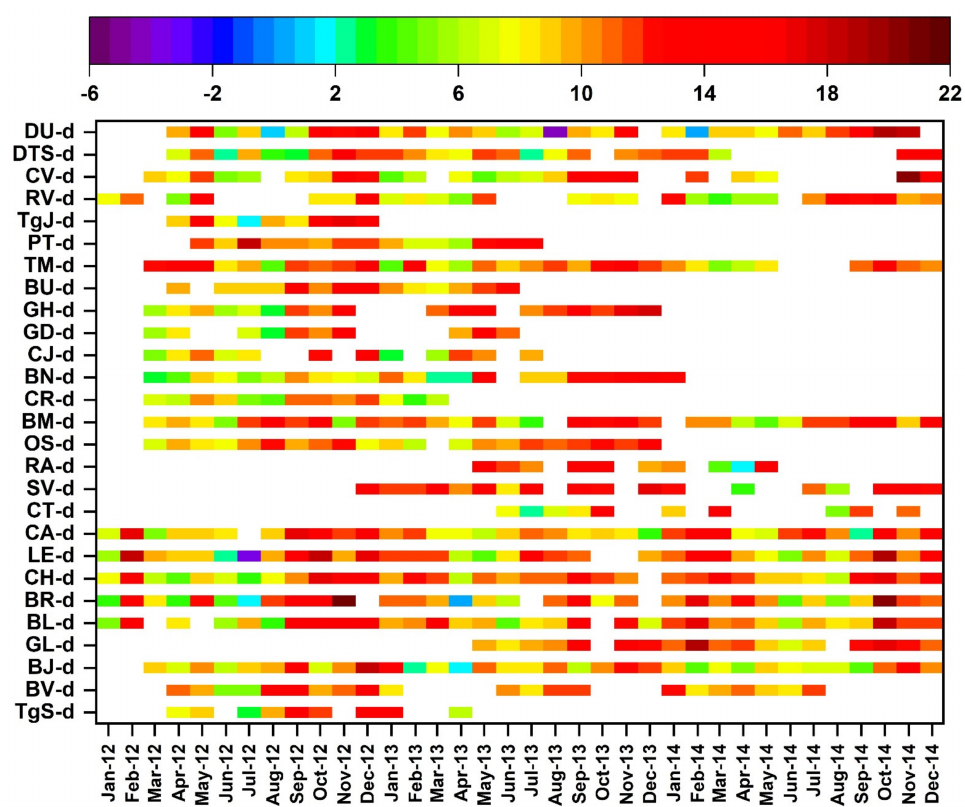
Figure 4. The temporal variation of d-excess values at the analyzed stations for the January 2012 to December 2014